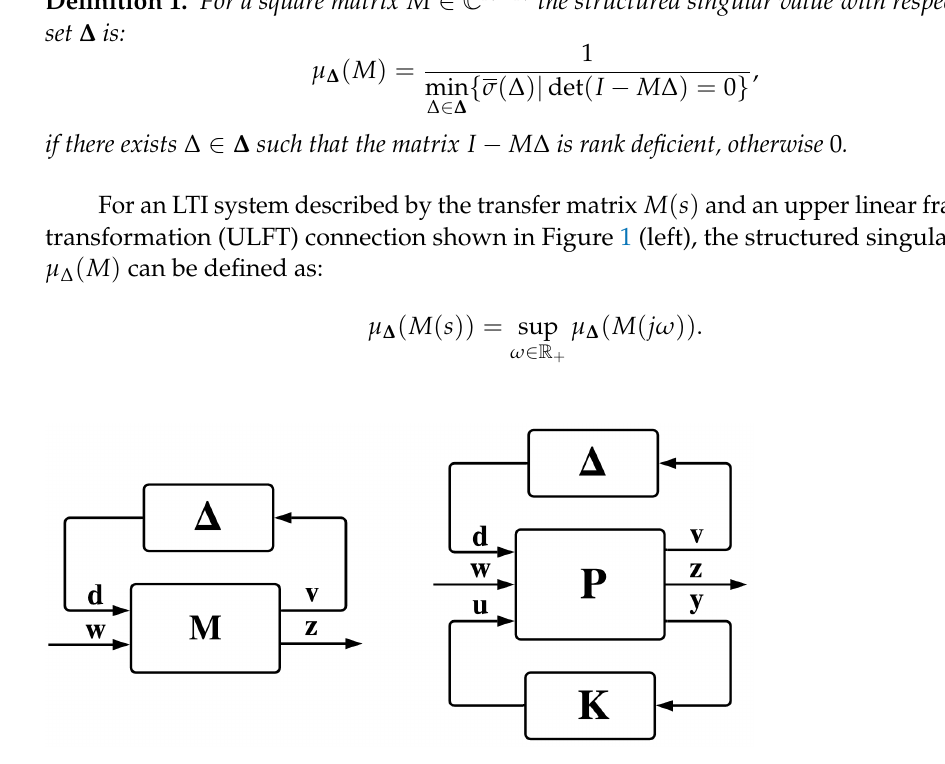
Figure 1. ( Left ) The generalized M- ∆ structure containing the plant and the uncertainty block ∆ . ( Right ) The closed-loop P- ∆ -K structure containing the plant, controller and uncertainty block ∆